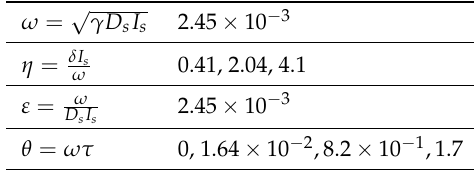
Table A1. Dimensionless parameters and their